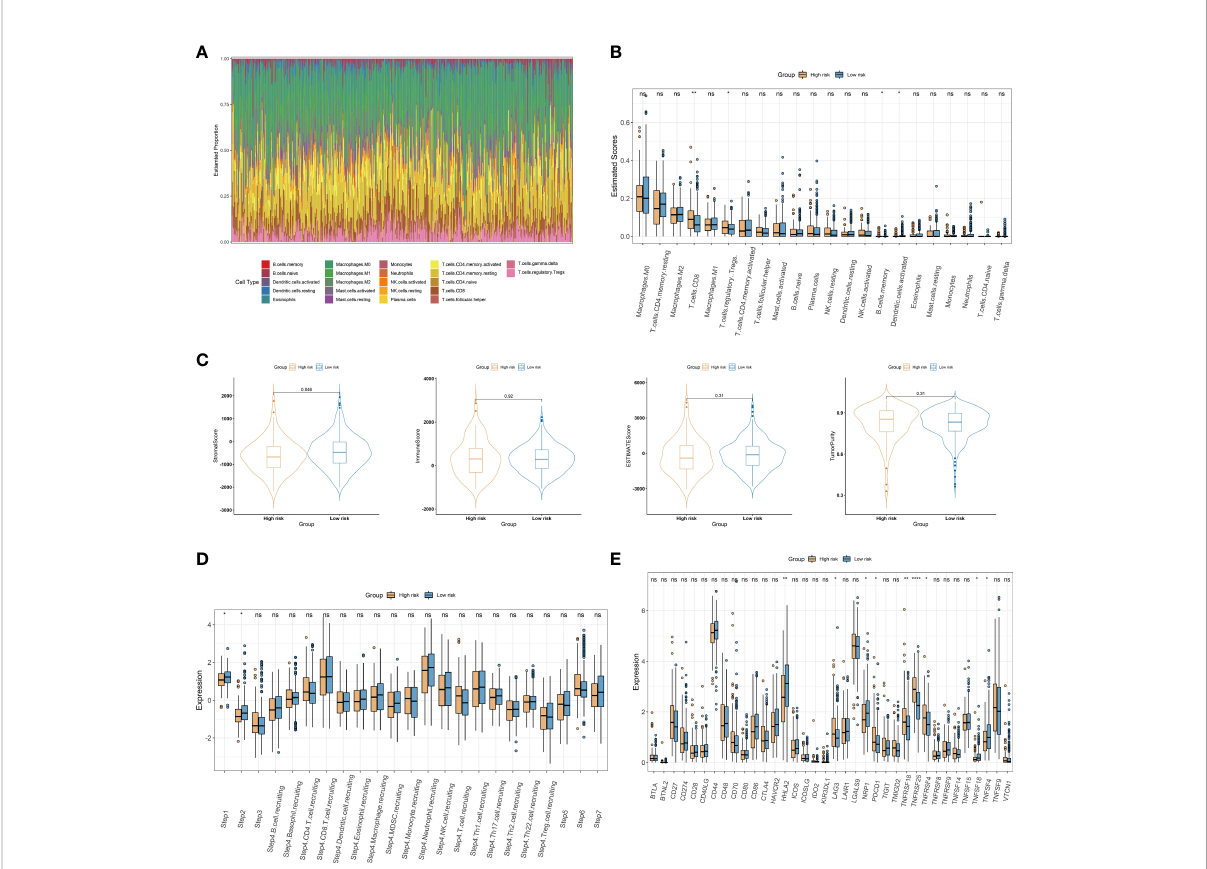
FIGURE 9 Association of the choline metabolism-related signature with the immune microenvironment. (A) Stacked bar plot of immune cell proportions in all COAD patients. (B) Comparison of twenty-two immune cell subsets in the high- and low-risk groups. (C) Differences in the stromal score, the immune score, the ESTIMATE score, and tumor purity between the two risk subgroups. (D) Comparison of antitumor immune status between the high- and low-risk groups. (E) Expression of immune checkpoints in the two risk subgroups *p< 0.05; **p< 0.01; ****p< 0.0001; ns, not signi fi